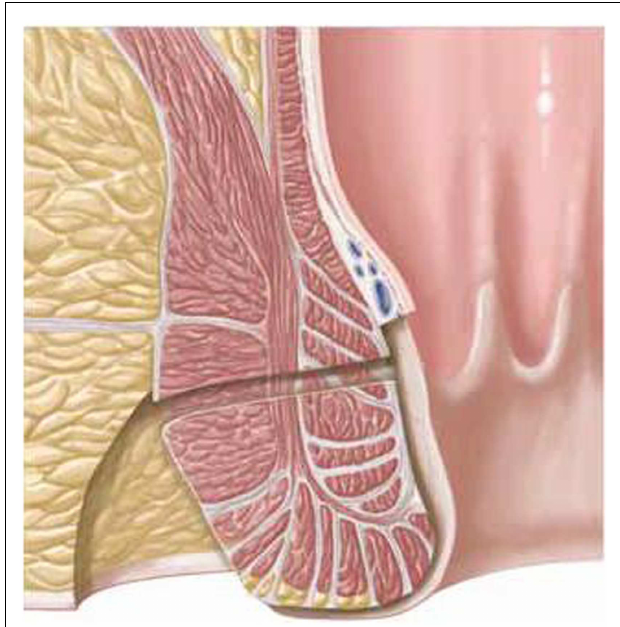
FIGURE 3 | Limited or partial fistulectomy with preservation of the sphincter muscle .The external opening, the extrasphincteric part of the fistula, and the internal opening are removed.